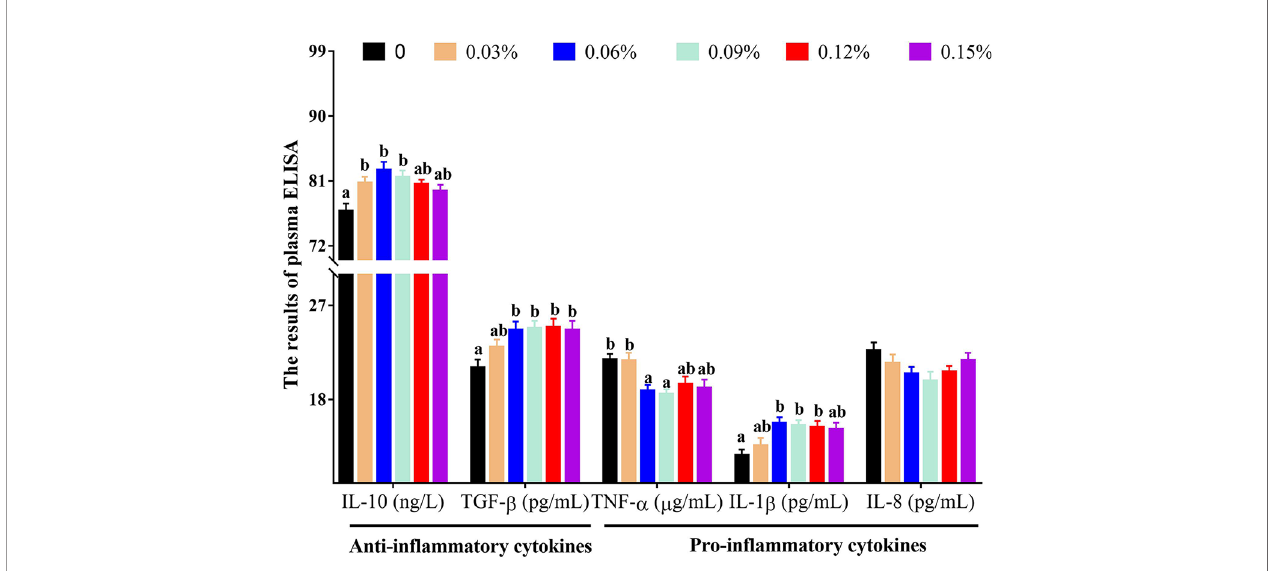
FIGURE 3 | The contents of plasma in fl ammatory cytokines with different levels of TB supplementation. IL-10, interleukin 10; TGF- b , transforming growth factor- b ; TNF- a , tumor necrosis factor- a ; IL-1 b , interleukin 1 b ; IL-8, interleukin 8. Data are expressed as means with S.E. Value with different superscripts are signi fi cantly different (P <